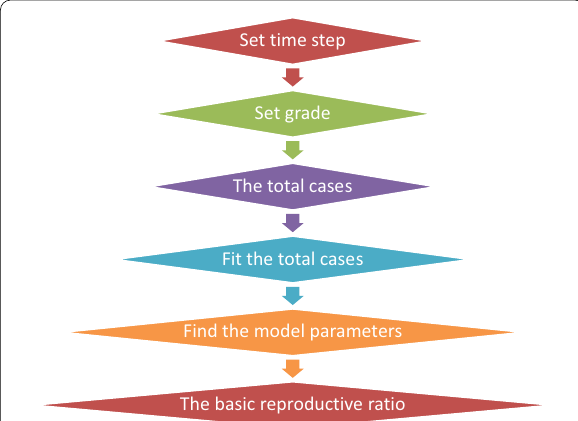
Fig. 2 A schematic graph of the numerical simulation algorithm which we used for the fitting of the SIRD model of MPVD, and finding the basic reproductive ratio of the MPVD